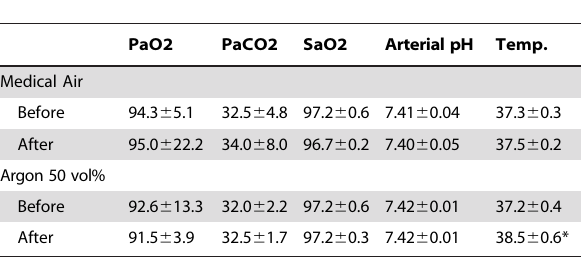
PaO2 PaCO2 SaO2 Arterial pH